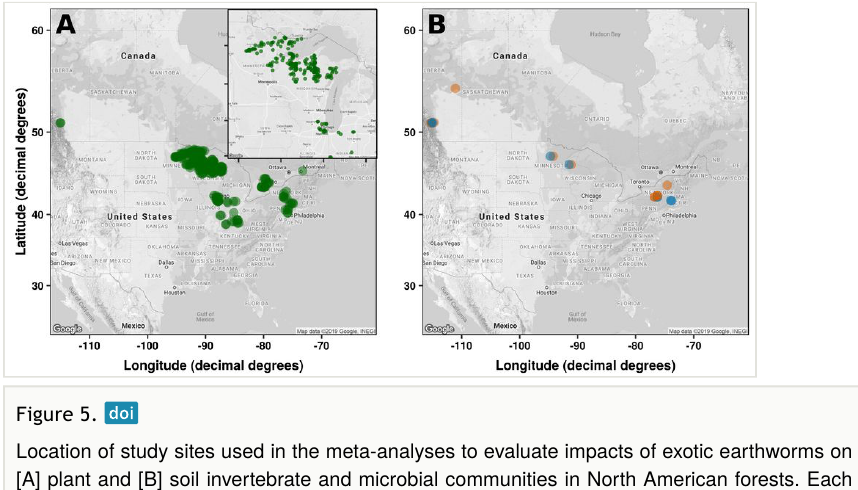
Location of study sites used in the meta-analyses to evaluate impacts of exotic earthworms on [A] plant and [B] soil invertebrate and microbial communities in North American forests. Each point corresponds to study sites (particular studies had multiple sites). Green: plant communities, orange: soil invertebrates, blue: soil microbial